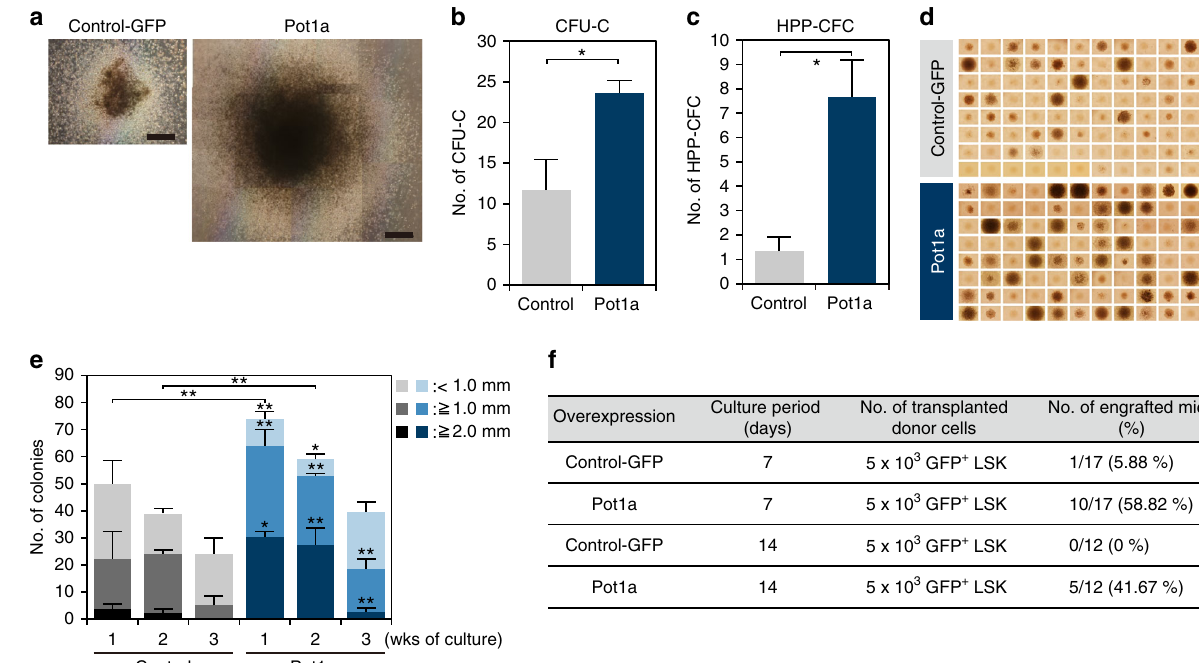
Fig. 2 Overexpression of Pot1a enhances HSC proliferation activity. a – c Control GFP or Pot1a-transduced LSK cells isolated from 8 week-old mice were cultured for 2 weeks and their ability to form colonies was analyzed. a Representative colonies from control GFP ( left ) and Pot1a-transduced LSK cells ( right ) after 2 weeks in vitro culture. Scale bar , 0.5 mm. b Number of CFU-Cs. c Number of HPP-CFCs. Data are expressed as the mean ± SD ( n = 3, * p < 0.01 by t -test). d , e Control GFP or Pot1a-transduced LSK cells were clone-sorted and cultured for 2 weeks in SF-O3 medium supplemented with SCF (20 ng ml – 1 ), TPO (50 ng ml – 1 ), IL-3 (20 ng ml – 1 ) and EPO (1 U ml – 1 ). d Development of colonies from single cells after 2 weeks in vitro culture. e Number of colonies derived from single cells after 1 – 3 weeks in vitro culture. Each colony was classi fi ed into three categories by their size ( < 1 mm, ≥ 1 mm, ≥ 2 mm). Data are expressed as the mean ± SD ( n = 3, * p < 0.01, ** p < 0.05 by Tukey ’ s test). f Control GFP or Pot1a-transduced 8 week-old LSK cells were cultured for 7 – 14 days. Subsequently, 5 × 10 3 GFP + LSK cells were transplanted into lethally irradiated mice. The number of recipient mice that showed long-term reconstitution of donor cells ( > 1% of GFP + Ly5.1 + cells in PB) is